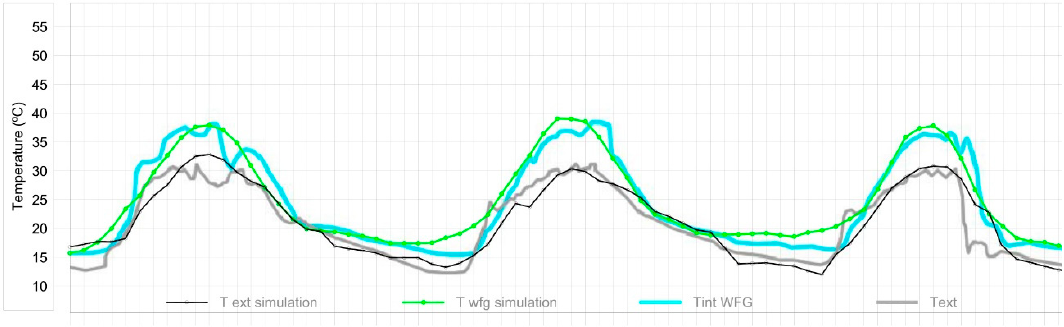
Figure 9. Performance of WFG. Room indoor temperature in the WFG cabin and outdoor temperature. Comparison between simulation results calculated with the tool and real data from the prototype. Sample summer days: 23/08/2010, 24/08/2010, and 25/08/2010.